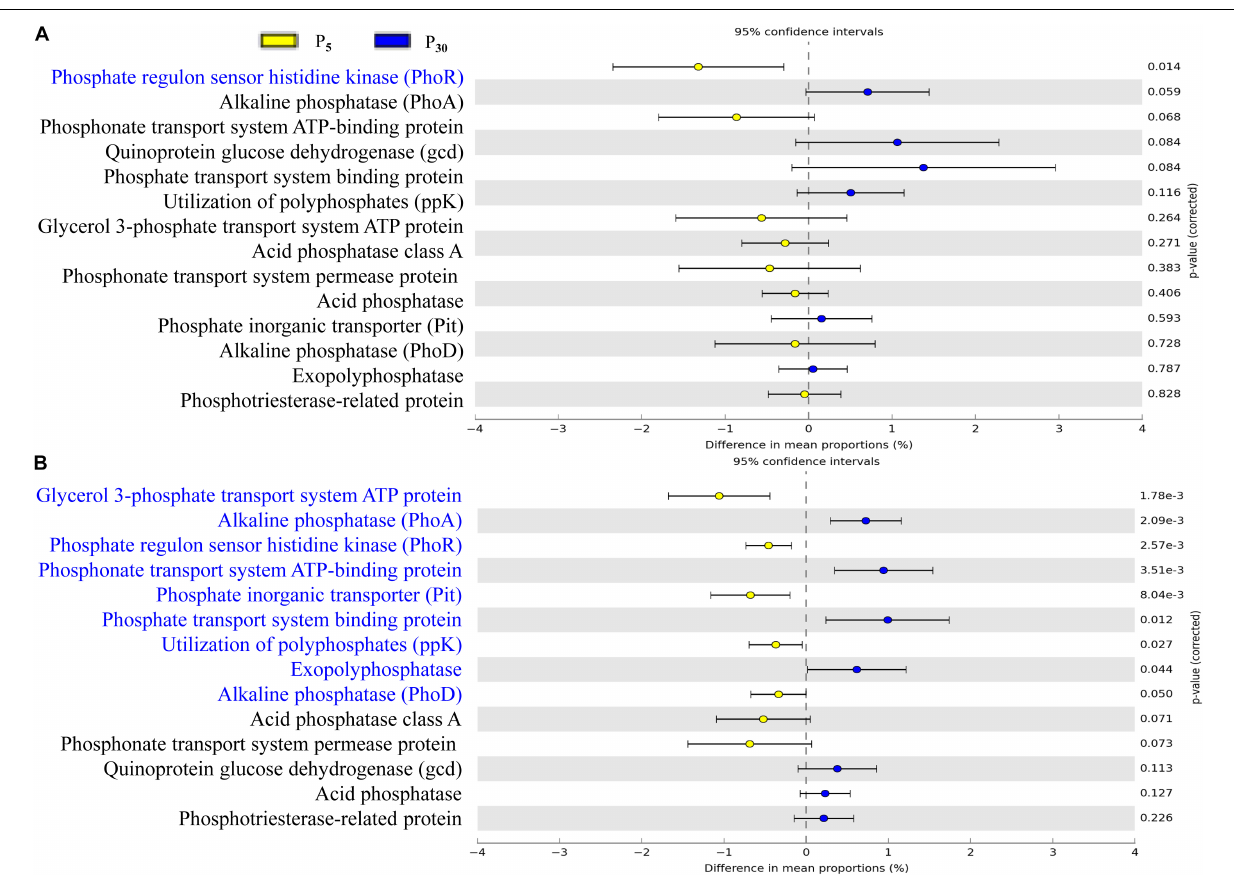
( Figure 7A ). The genes of phosphate regulon sensor histidine kinase (Pho R), alkaline phosphatase (Pho A),